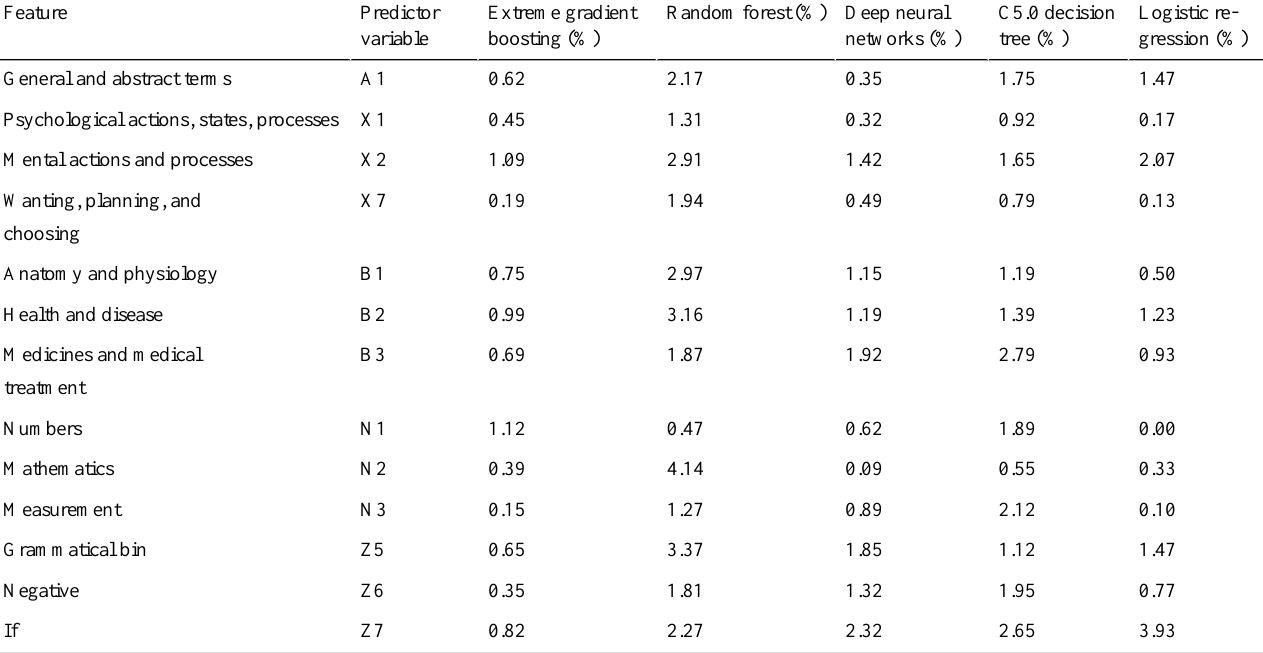
Table 6. Mean decrease in the area under the receiver operating characteristic curve of the 5 machine learning algorithms.